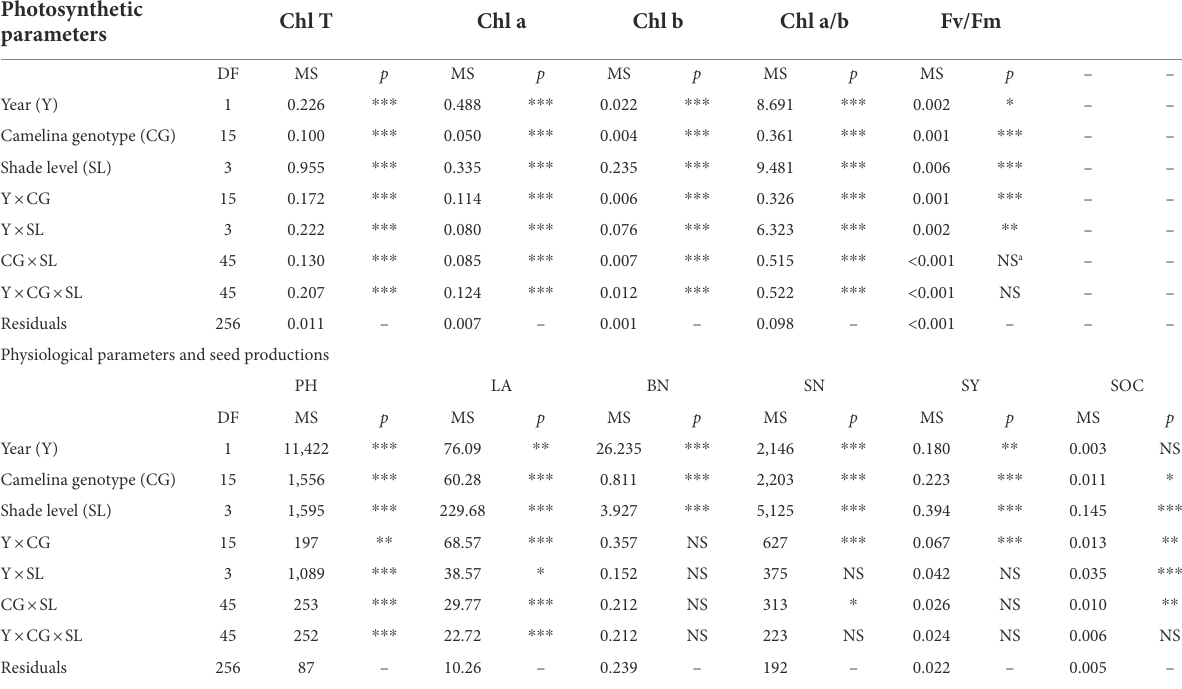
TABLE 2 Effect of fixed sources of variation on photosynthetic and physiological parameters and seed production of camelina grown under different shade treatments. Source Photosynthetic Chl T parameters